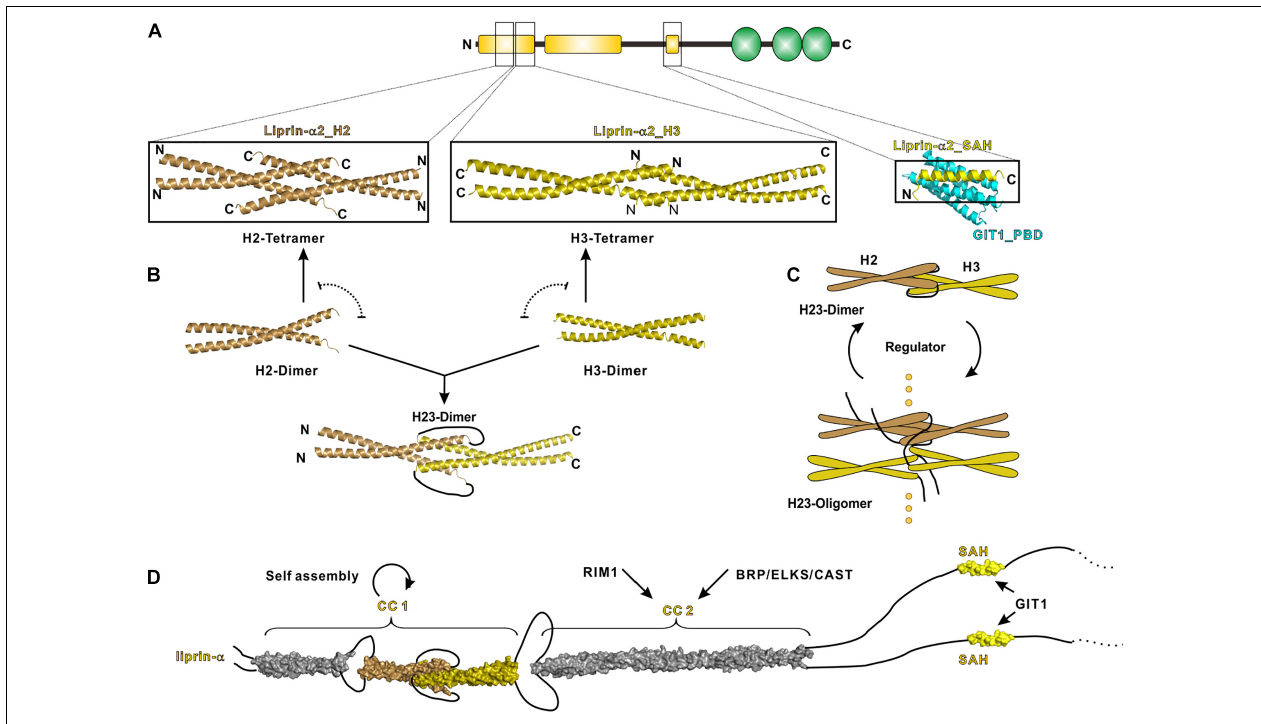
FIGURE 3 | N-terminal coiled coils mediate the self-assembly of liprin- α . (A) The solved structures of liprin- α N-terminus were indicated by black boxes. The H2 (PDB id: 7D2H), H3 (7D2E), and SAH (6IUH) segment structures of liprin- α 2 were shown. (B) A model indicating that the dimeric H2 and H3 competitively transit between homo-tetramers and a H23-dimer. (C) A schematic cartoon showing the self-assembly mechanism of liprin- α CC1. The transition between dimers and higher oligomers may be controlled by unknown regulators. (D) A structure model showing the complete N-terminal structure of liprin- α . The H1 segment and CC2 was modeled as coiled coils and shown in